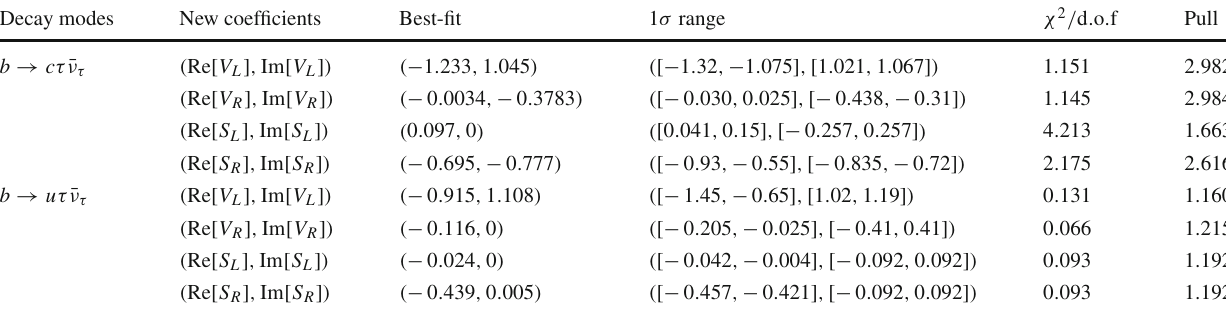
Table 3 Best-fit values and corresponding 1 σ ranges (for one benchmark set only) of the new complex coefficients Decay modes New coefficients Best-fit 1 σ